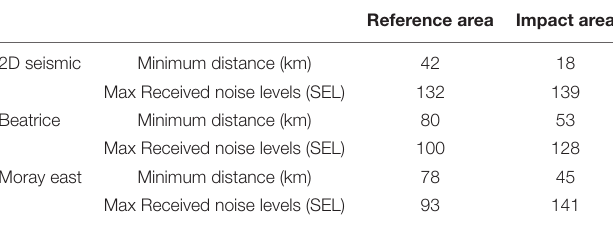
TABLE 1 | Summary table with distance to the offshore project and maximum predicted received noise levels expressed as unweighted single-pulse